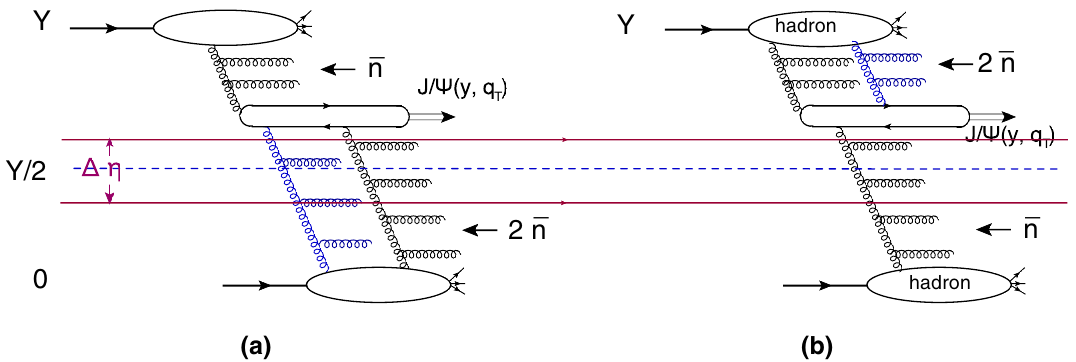
the observed enhanced multiplicity (measured in the bin Δη ) either to